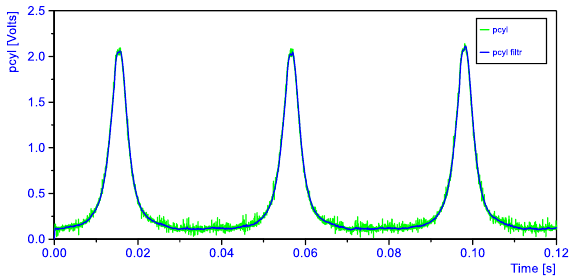
Fig. 4. The signal from the pressure sensor in the first cylinder